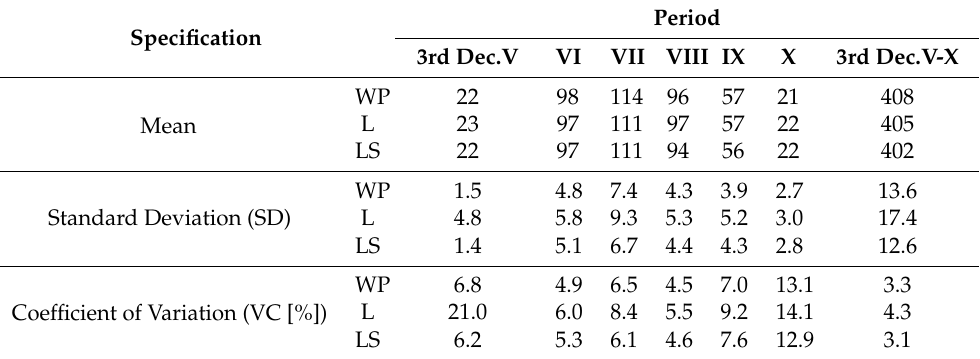
Table 3. Statistical characteristics of willow water needs in the period 1981–2010 determined as ETp [mm].